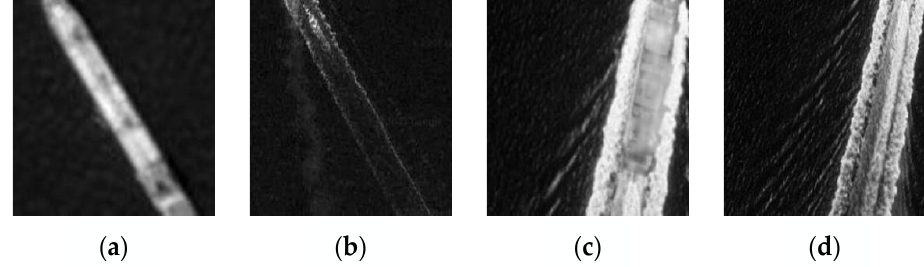
Figure 7. Similarity between ship wake waves and target edge. ( a , c ) Ship targets. ( b , d ) Ship-like wake waves.